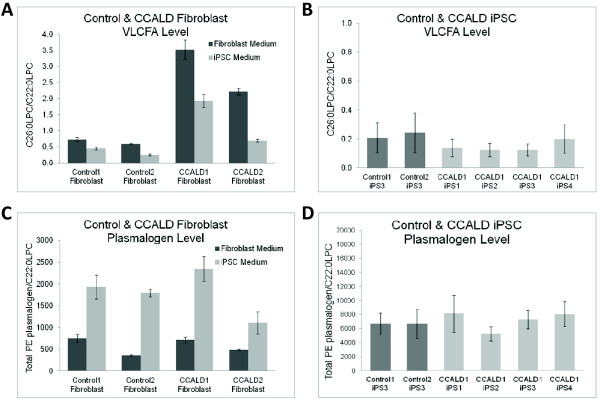
Comparison of saturated very long chain fatty acid (sVLCFA) and plasmalogen levels in patient and healthy control fibroblasts and iPSCs. (A) Relative sVLCFA levels in patient and healthy control fibroblasts grown in fibroblast media or iPSC media, as represented by the C26:0/C22:0 LPC (lysophosphatidylcholine) ratio; (B) Relative sVLCFA levels in patient and healthy control iPSC clones grown in induced pluripotent stem cell (iPSC) media, again represented by the C26:0/C22:0 LPC ratio; (C) Relative plasmalogen level in patient and healthy control fibroblasts grown in fibroblast media and iPSC media, as represented by the total phosphatidyl ethanolamine (PE) plasmalogen/C22:0 lysophosphatidylcholine (LPC) ratio; (D) Relative plasmalogen in patient and healthy control iPSC clones grown in iPSC media, again represented by the total PE plasmalogen/C22:0 LPC ratio.